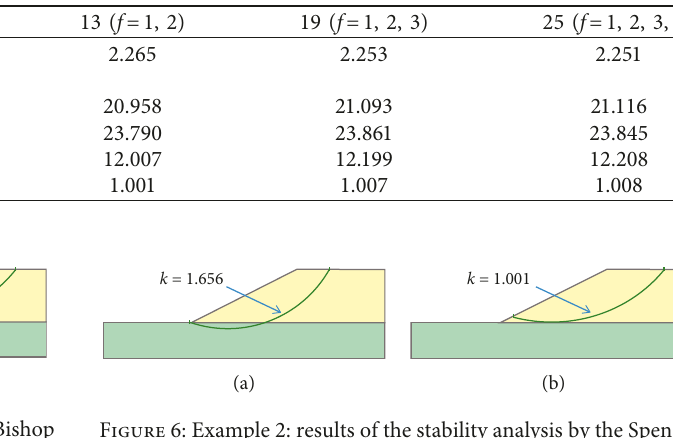
Table 8: Results of probabilistic analysis by the Spencer method for Example 2.